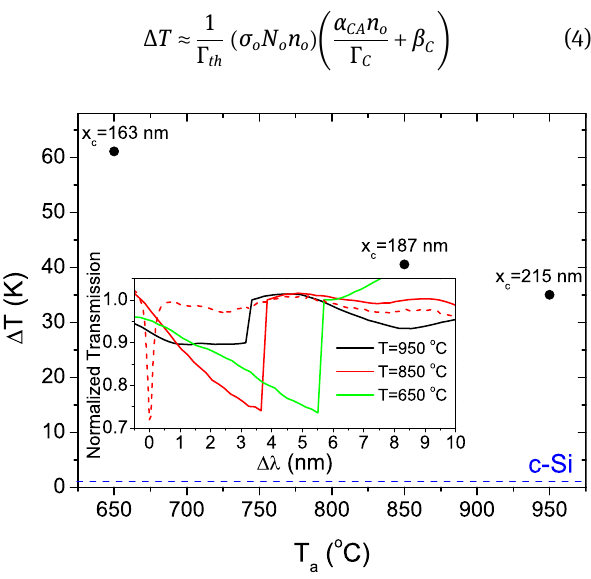
Figure5: TemperatureincreaseofOMCnanobeamsfabricatedinnc- SOI wafers with different annealing temperature T a for a fi xed photon number of 2.7 × 10 3 . The dashed horizontal line corresponds to the value extracted from the measurements of the c-Si reference sample. The average nanocrystallite size ( x c ) is also shown. The inset shows the transmission curves with respect to the resonance value, at low laser power,obtainedatthesamevalueofthemaximumintracavityphoton number ( n o ,max ). The transmission signals, which arise from the interplay of the Free carrier absorption (FCA) and the TO effect, are normalized to the values just after the resonance is lost. The red dashed curve illustrates a transmission curve at low laser power measured from sample OMS3 ( T a = 850 ° C) so that no signi fi cant TO effect is observed. nc-Si, nanocrystalline silicon; OMC, nanoscale optomechanical cavity; nc-SOI, nanocrystalline silicon (nc-Si)-on- insulator; TO,